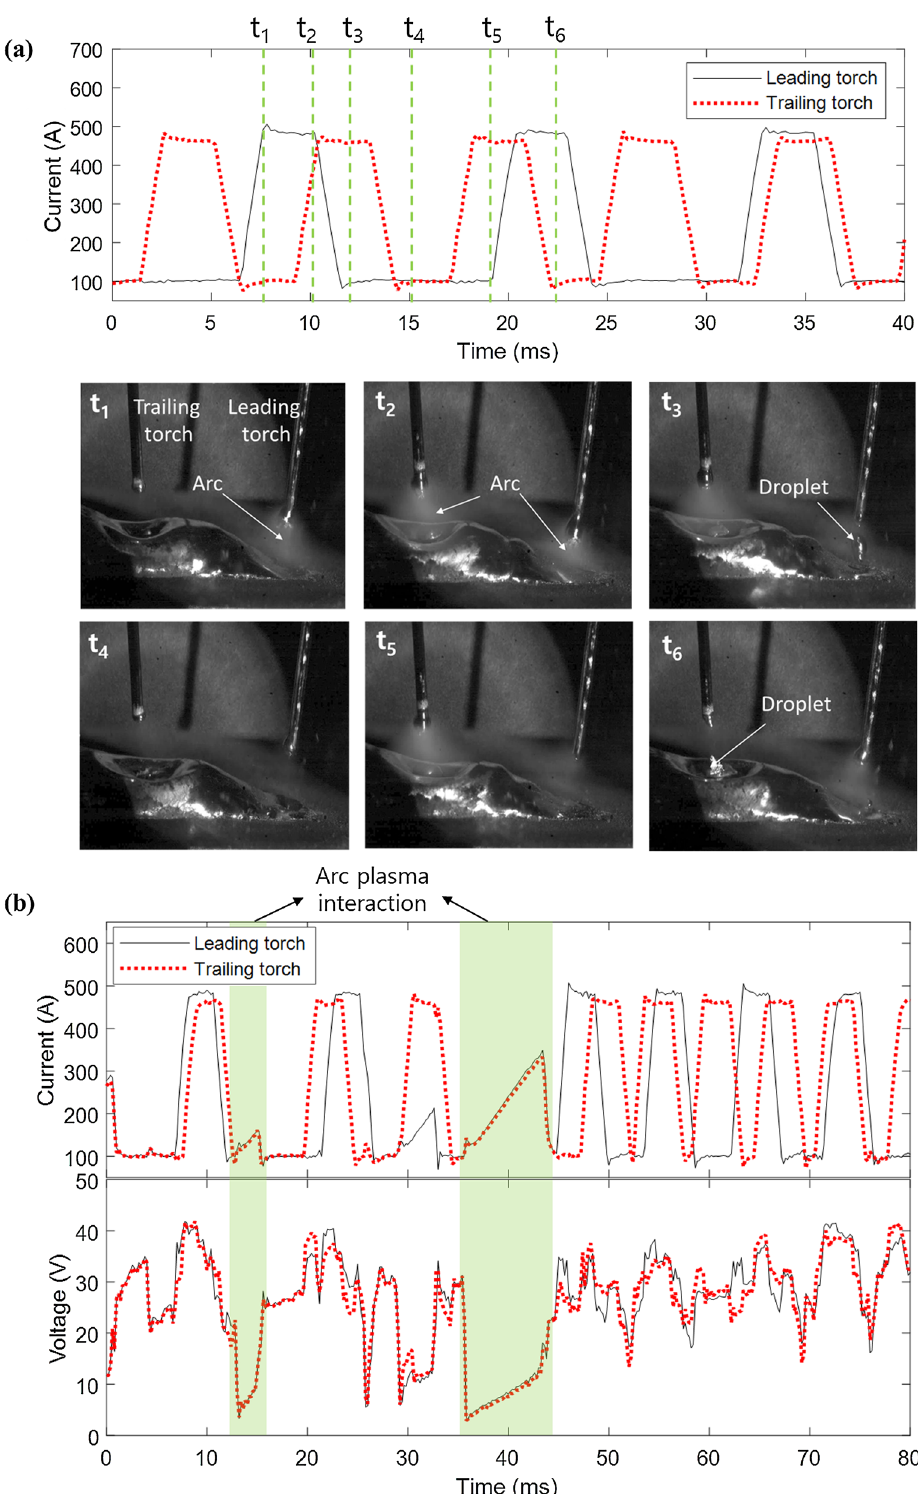
Figure 1. Asynchronous tandem welding mechanism and problem. ( a ) Tandem welding pulse current and molten metal transfer and ( b ) destroyed pulse current and voltage by arc interruption in tandem welding (color